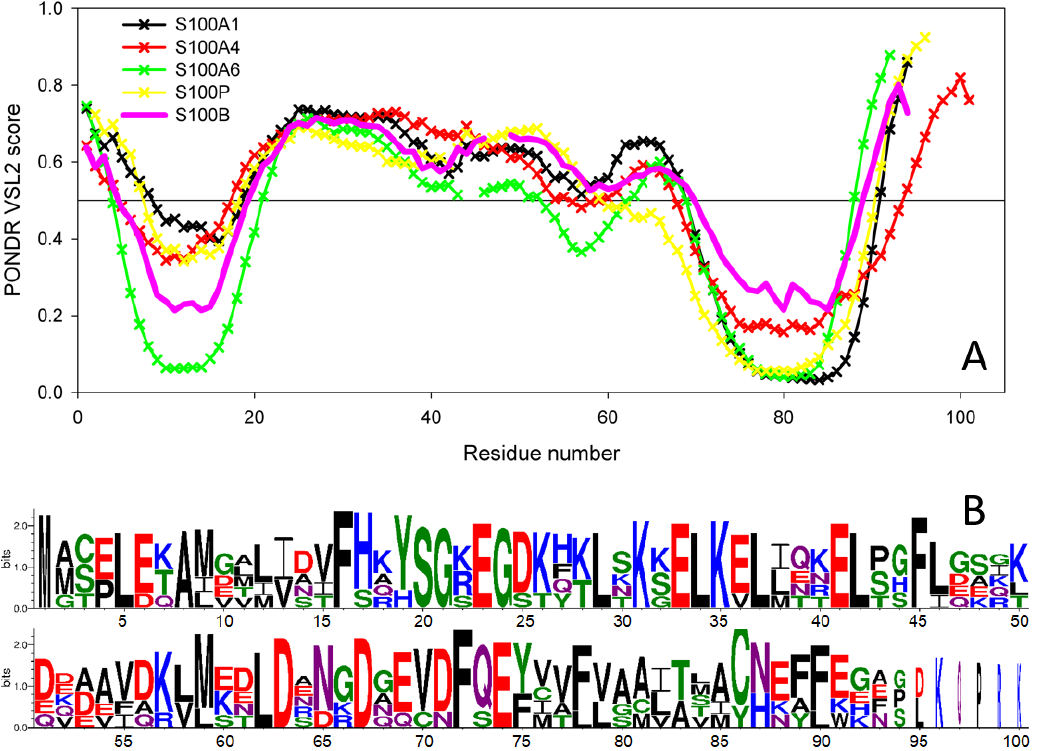
Figure 7. ( A ) Intrinsic disorder predisposition of human S100B protein in comparison with the disorder profiles of human S100 proteins capable of IFN- β binding, estimated using PONDR ® VSL2 algorithm (http://www.pondr.com/ accessed on 26 November 2021). The plot represents data for the sequences aligned using Clustal Omega [64], and breaks in the curves correspond to the alignment gaps. ( B ) Sequence logo representation of human S100B, S100A1, S100A4, S100A6, and S100P proteins generated by the WebLogo tool (http://weblogo.threeplusone.com/ accessed on 26 November 2021)